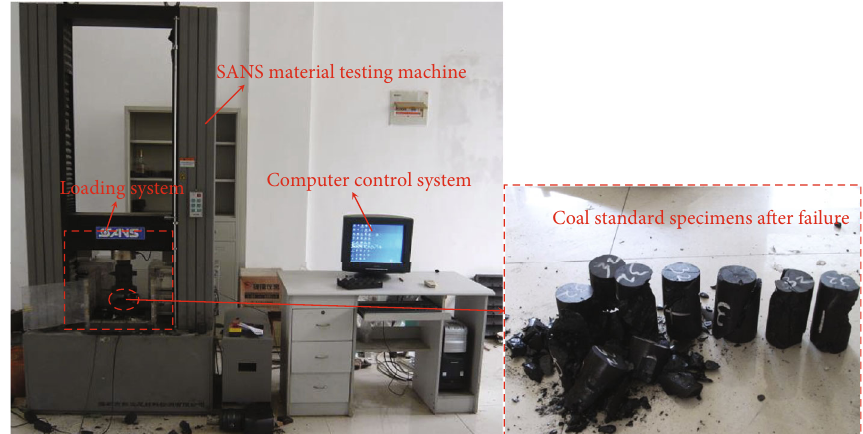
Figure 5: The SANS material testing machine. Table 2: The parameters of dynamic failure time ( D